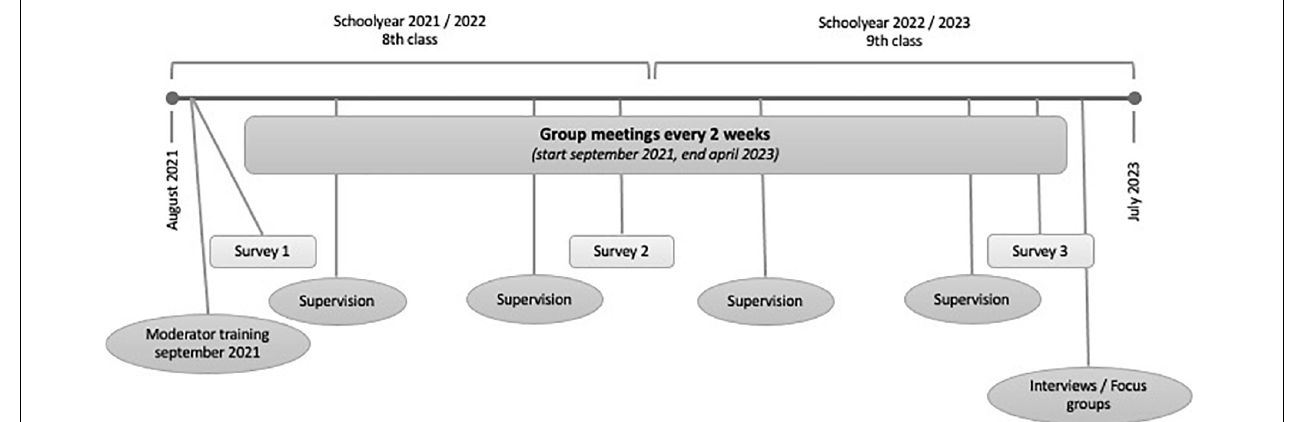
FIGURE 3 | Overview of the methodological design of the project “Empower Peers 4